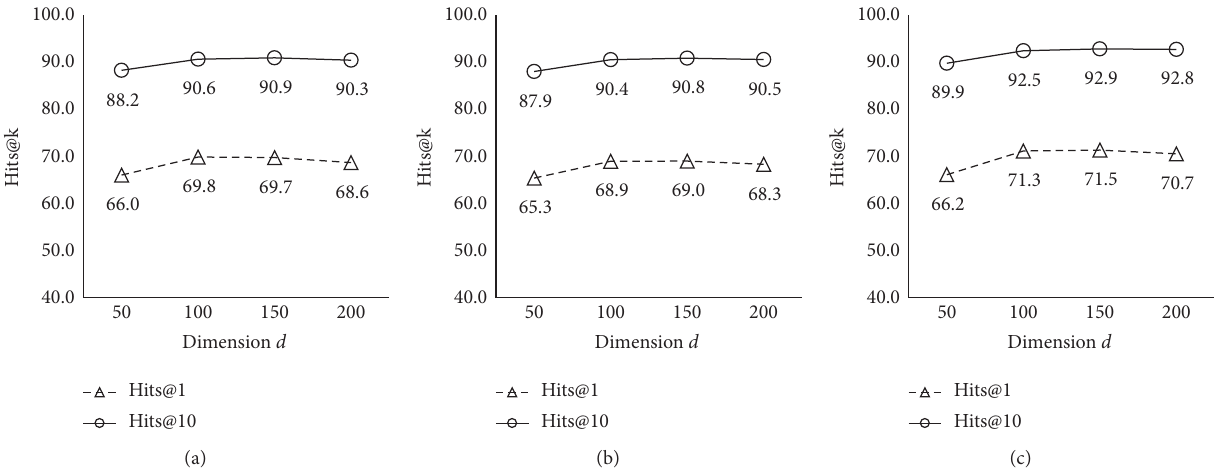
Figure 5: CAREA performance with respect to the feature dimension d . (a) DBP